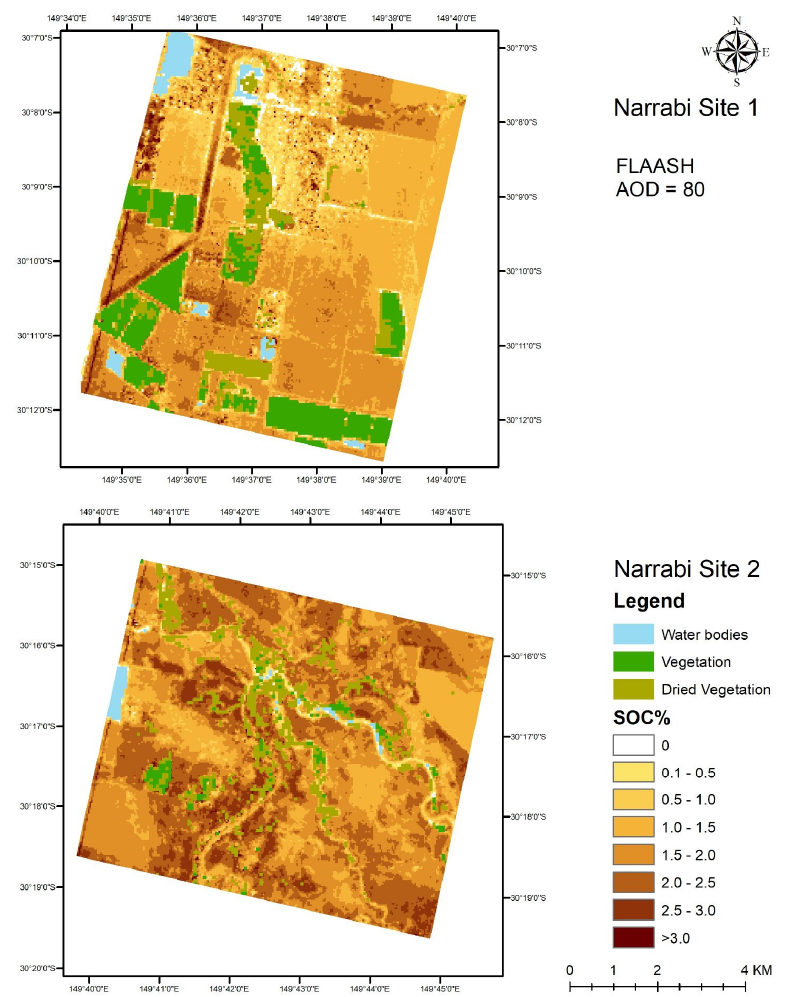
Figure 9. SOC prediction maps using an AOD of 80 with FLAASH method. It is observed that there is a slight deviation in the spectral signatures with varying AOD in the VNIR region of 400 to 1100 nm and no deviation in the rest of the spectrum Variation in the SOC content of the pixels adjacent and in between vegetation pixels up to 2400 nm (Figure 6). The percentage of bare soil pixel is very consistent 82.35% and can also be observed. This can be clearly seen in the Standard Deviation map (Figure 10). good consistency is observed for the significant wavelengths for the prediction model with A higher standard deviation along the riverbed in site#2 is observed. This may be due to FLAASH atmospheric correction (Table 4). Hence due to these observations, consistency no bare soil and a mixture of water, green, and dry vegetation. High standard deviation can be observed in the model performance across varying AOD levels. is observed in areas that have negative values with AOD = 0.2 and AOD > 1.0. The range of AOD in the Narrabri region varies from 0.02 to 1.5 as per Table 1. Comparing the SOC maps obtained by varying the AOD level with the exception of AOD level 0.2, good consistency prediction from AOD 0.4 to AOD 1.4 is observed. This is also confirmed by the histogram as per (Figure 8). The standard deviation map of SOC variation is fairly consistent with high variation at a few places. These places match with farm boundaries indicating inconsistencies at a farm